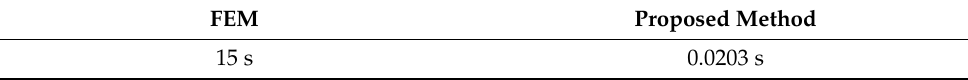
Table 5. Time performance comparison of the proposed method (time per operation).